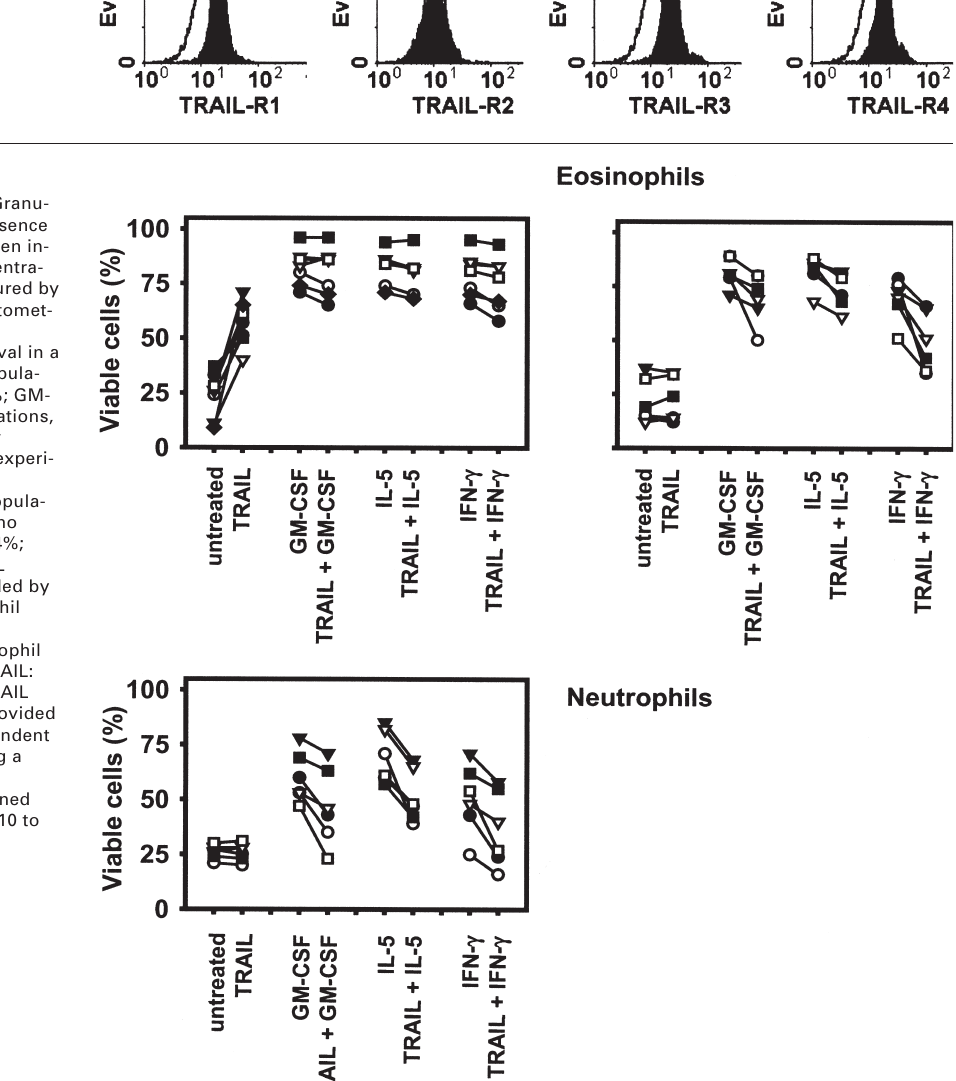
TRAIL receptor surface proteins are expressed by granulocytes. TRAIL receptors were de- tected by flow cytometry using specific mono- clonal antibodies. TRAIL-R1, TRAIL-R3, and TRAIL-R4, but not TRAIL-R2, were detected in both eosinophils and neutrophils. Specific staining is shown by filled curves and control antibody staining by open curves. These re- sults are representative of three independent experiments.